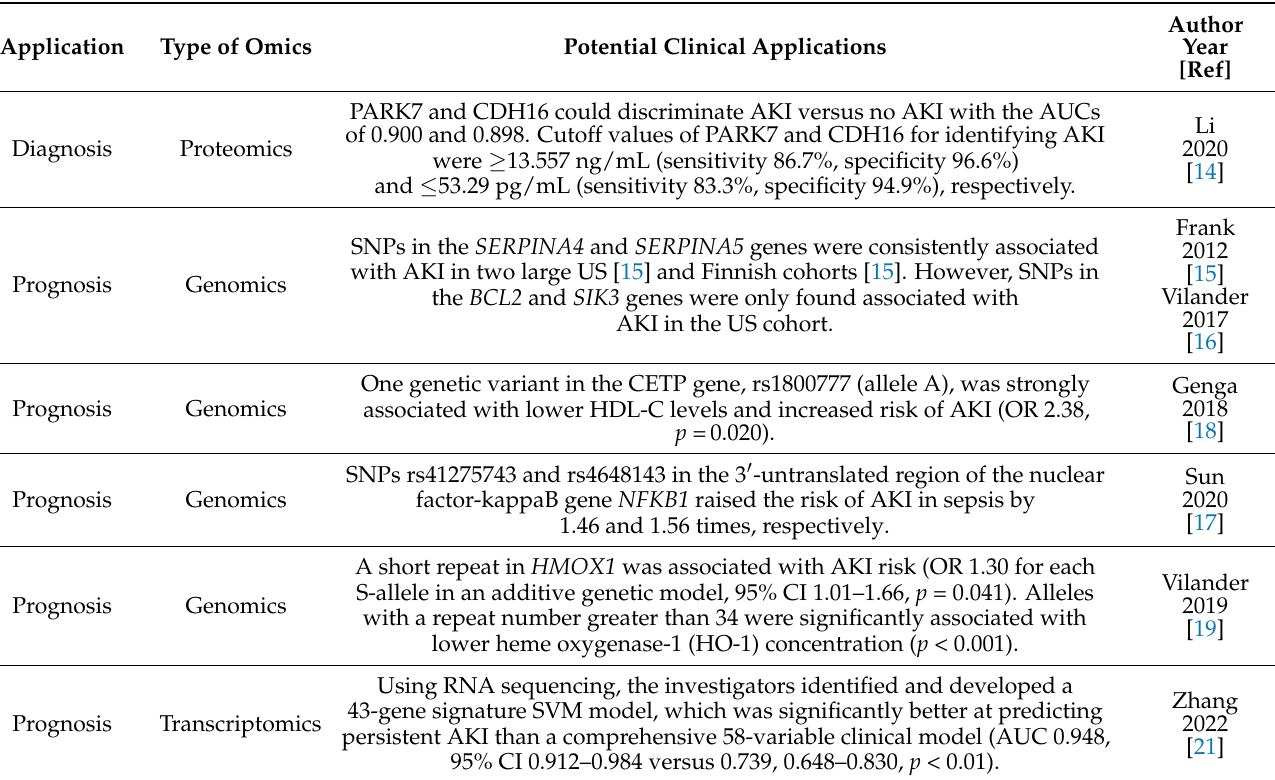
Table 1. Omics for acute kidney